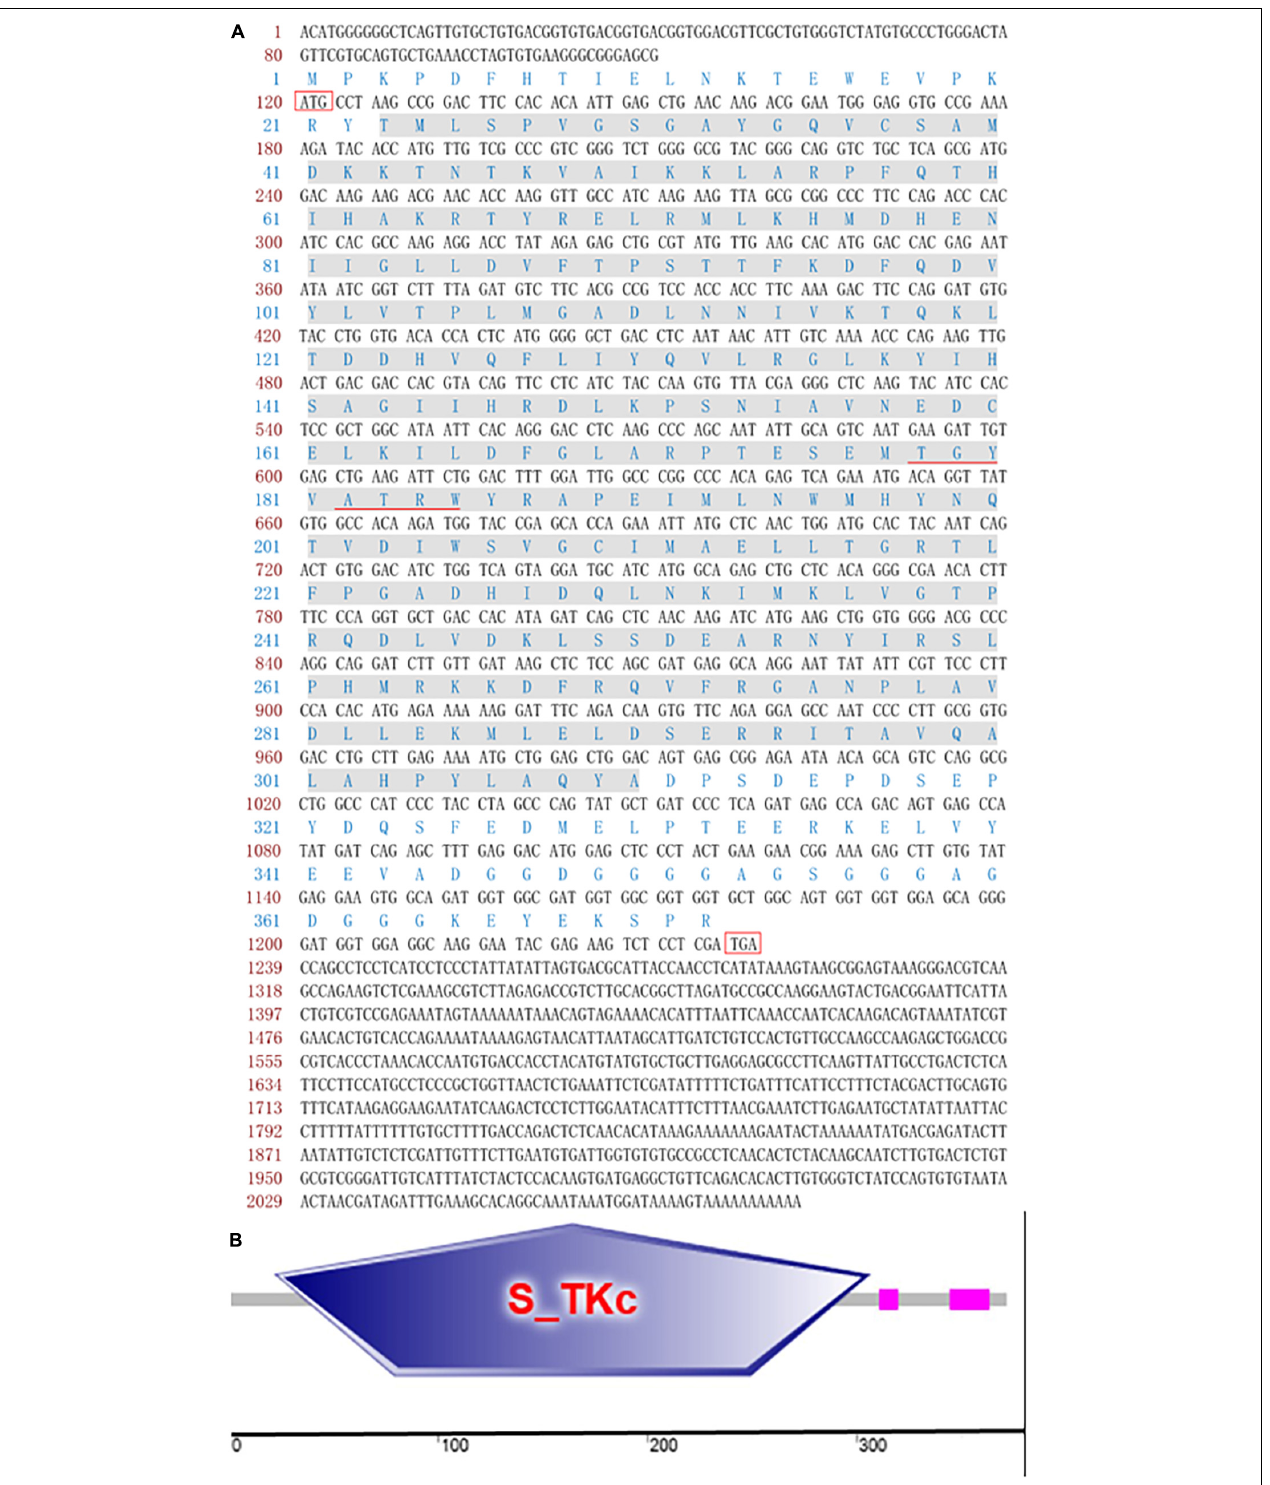
FIGURE 1 | Sequence and domain architecture of PtP38. (A) Full-length cDNA of PtP38. The corresponding amino acid sequence is shown above the nucleotide. The figure shows that the full-length cDNA of PtP38 consists of a 119-bp 5 (cid:48) untranslated region, an 849-bp 3 (cid:48) untranslated region, and a 1,116-bp open reading frame. The coding region encodes 372 amino acids. The gray-highlighted sequence represents the S_TKc domain, and the underlined sequences denote the conserved TGY motif and ATRW sites. (B) The domain architecture of PtP38 is predicted by SMART (http://smart.embl-heidelberg.de/). The PtP38 amino acid sequence contains an S_TKc domain, with a conserved TGY phosphorylation site and an ATRW substrate binding site.